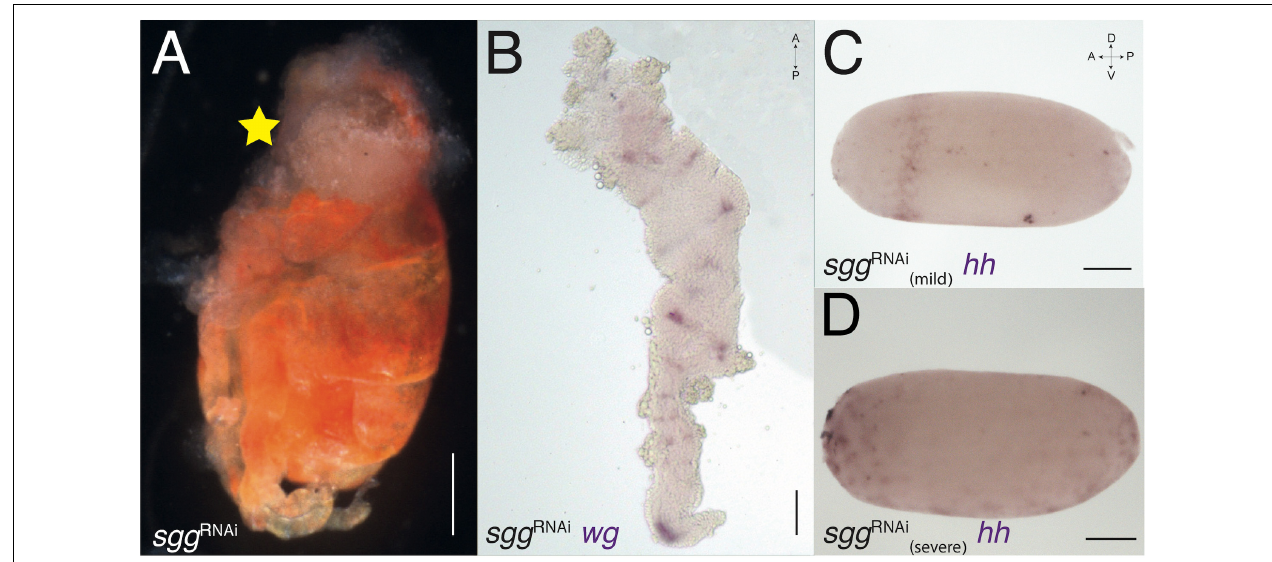
FIGURE 4 | sgg- RNAi phenotypes. (A) sgg- RNAi hatchling with no head (marked with yellow star) and a reduced abdomen (compare with Figure 3B ). (B) Expression of wg in sgg- RNAi germband embryo. The germband is severely deformed, with no head lobes and no pre-gnathal segments. The exact identity of the remaining segments is difficult to determine. (C) Expression of hh in sgg- RNAi blastoderm embryo with mild knock-down effect. The expression ring is jagged and not uniform. (D) Expression of hh in sgg- RNAi blastoderm embryo with severe knock-down effect showing patchy expression suggesting that the embryo did not develop at all. Axis labels: A, anterior; P, posterior; D, dorsal; V, ventral. All scale bars are 200 µ m.